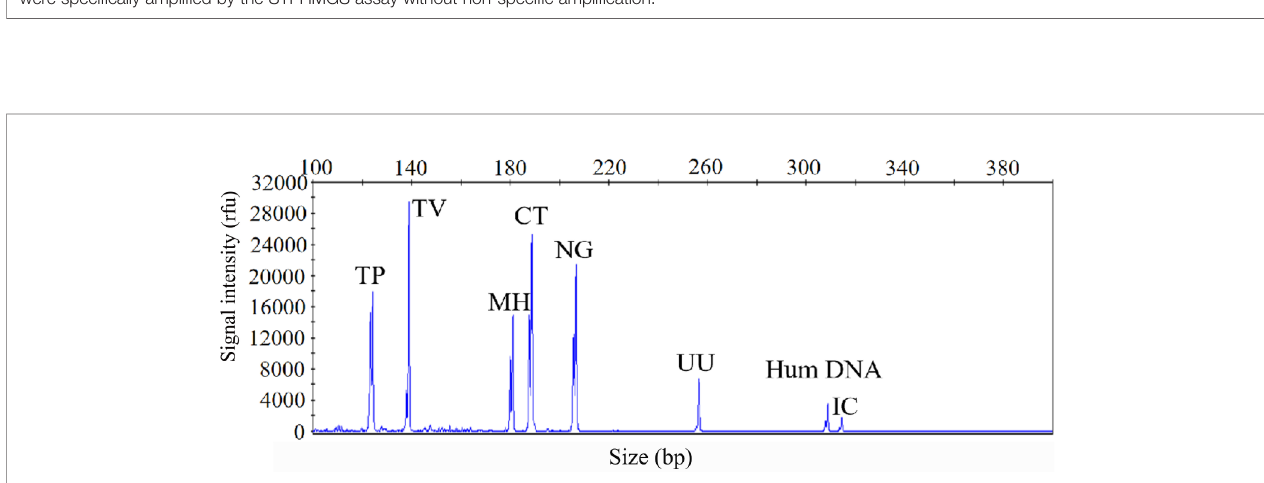
FIGURE 2 | The optimized sexually transmitted infection high-throughput multiplex gene detection system(STI-HMGS) assay exhibited high levels of sensitivity for the simultaneous detection of all six pathogens and control genes in a single PCR. The detection limits of the STI-HMGS assay when detecting pathogens were determined by amplifying plasmids (diluted by ten-fold) containing equal concentrations of 6 pathogens and 2 quality control templates at a concentration of 100 copies/µL. The six pathogen-de fi ning DNA targets all generated speci fi c peaks, from left to right are Treponema pallidum (TP), Trichomonas vaginalis (TV), Mycoplasma hominis (MH), Chlamydia trachomatis (CT), Neisseria gonorrhoeae (NG) and Ureaplasma urealyticumm (UU). The human internal DNA control gene (Hum DNA) and systematic internal control (IC) produced speci fi c peaks at 308bp and 315bp, respectively.